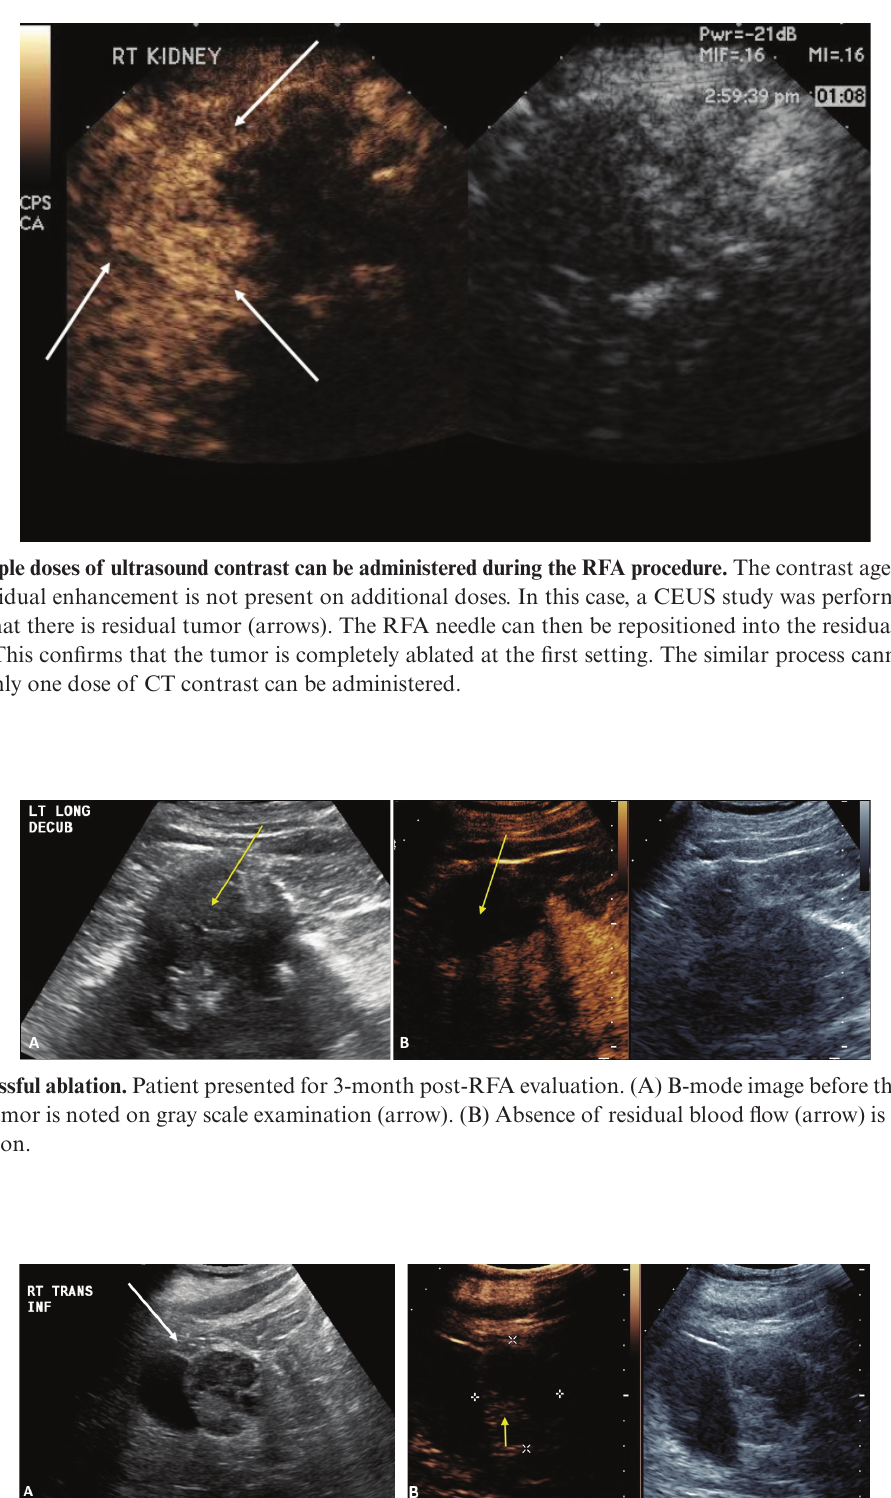
Figure 4. Tumor recurrence/inadequate ablation. Patient presented for CEUS examination 6 weeks after RFA. (A) The B-mode image demonstrates a complex mass (arrow) with solid and cystic components. It is not possible to determine if there is residual tumor. (B) CEUS image demonstrates the tumor (calipers) with residual flow in the posterior part of the tumor (arrow).